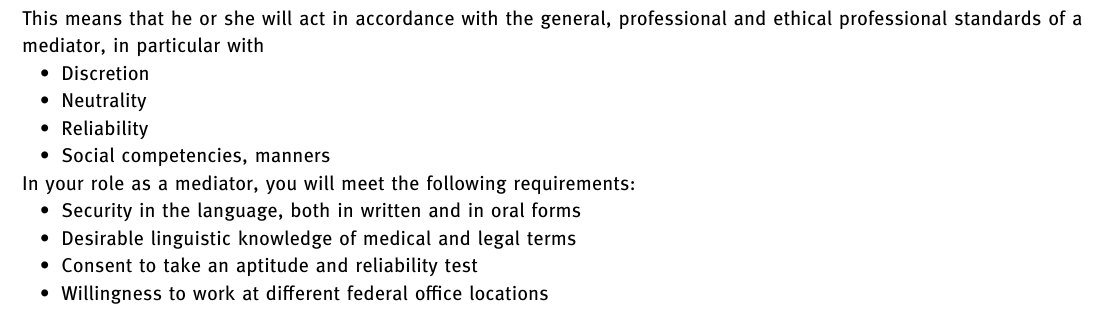
Table 1: Flyer for interpreters with the expectations from the Bamf to become an interpreter ( author ’ s translation